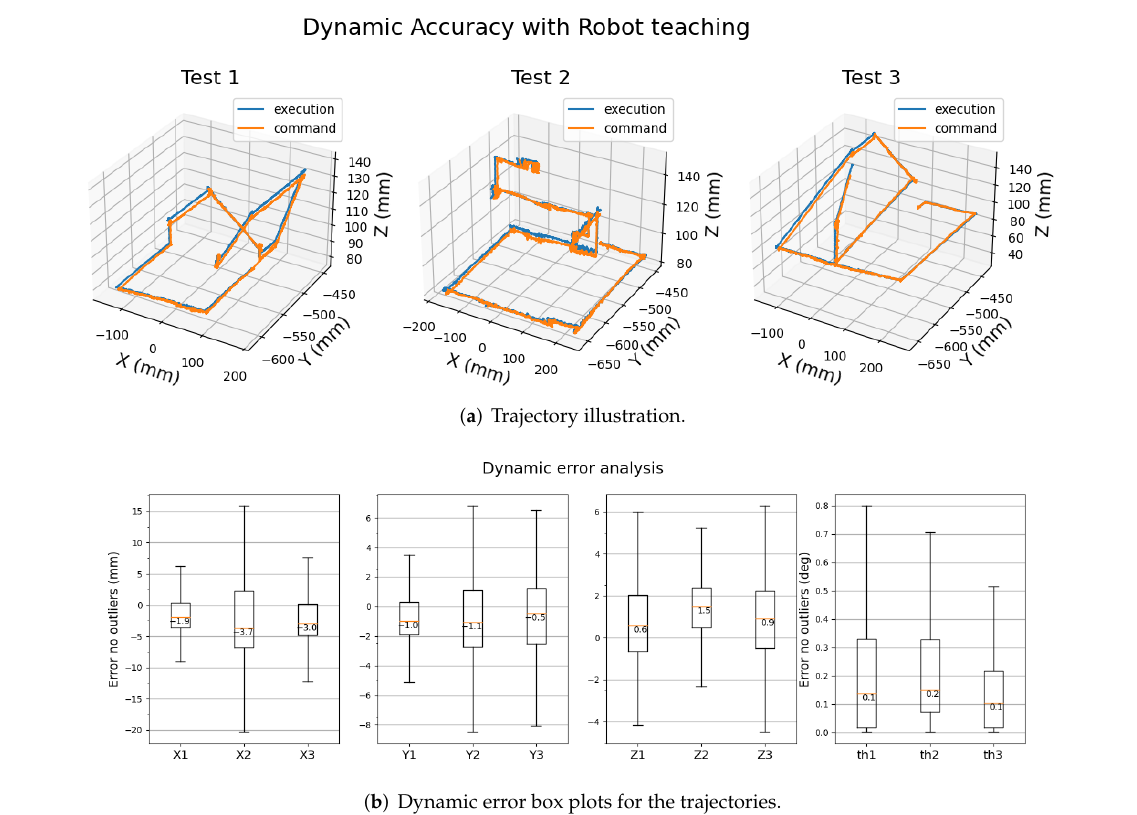
Figure 17. Dynamic accuracy with Robot teaching—Illustrative trajectories and error box plots. The box plots for three trajectories, each includes translation and rotation parts. Among the three trajectories, the errors in X translation appears to be the largest with 3.7 mm for X2. The largest error in Y belongs to Y2 at 1.1 mm, and Z2 also tops at 1.5 mm. The average of all trajectories per axis are 2.79 mm, 1.09 mm, and 1.44 mm for X, Y, and Z axis, respectively. For rotation, the error is slightly higher than 0.1